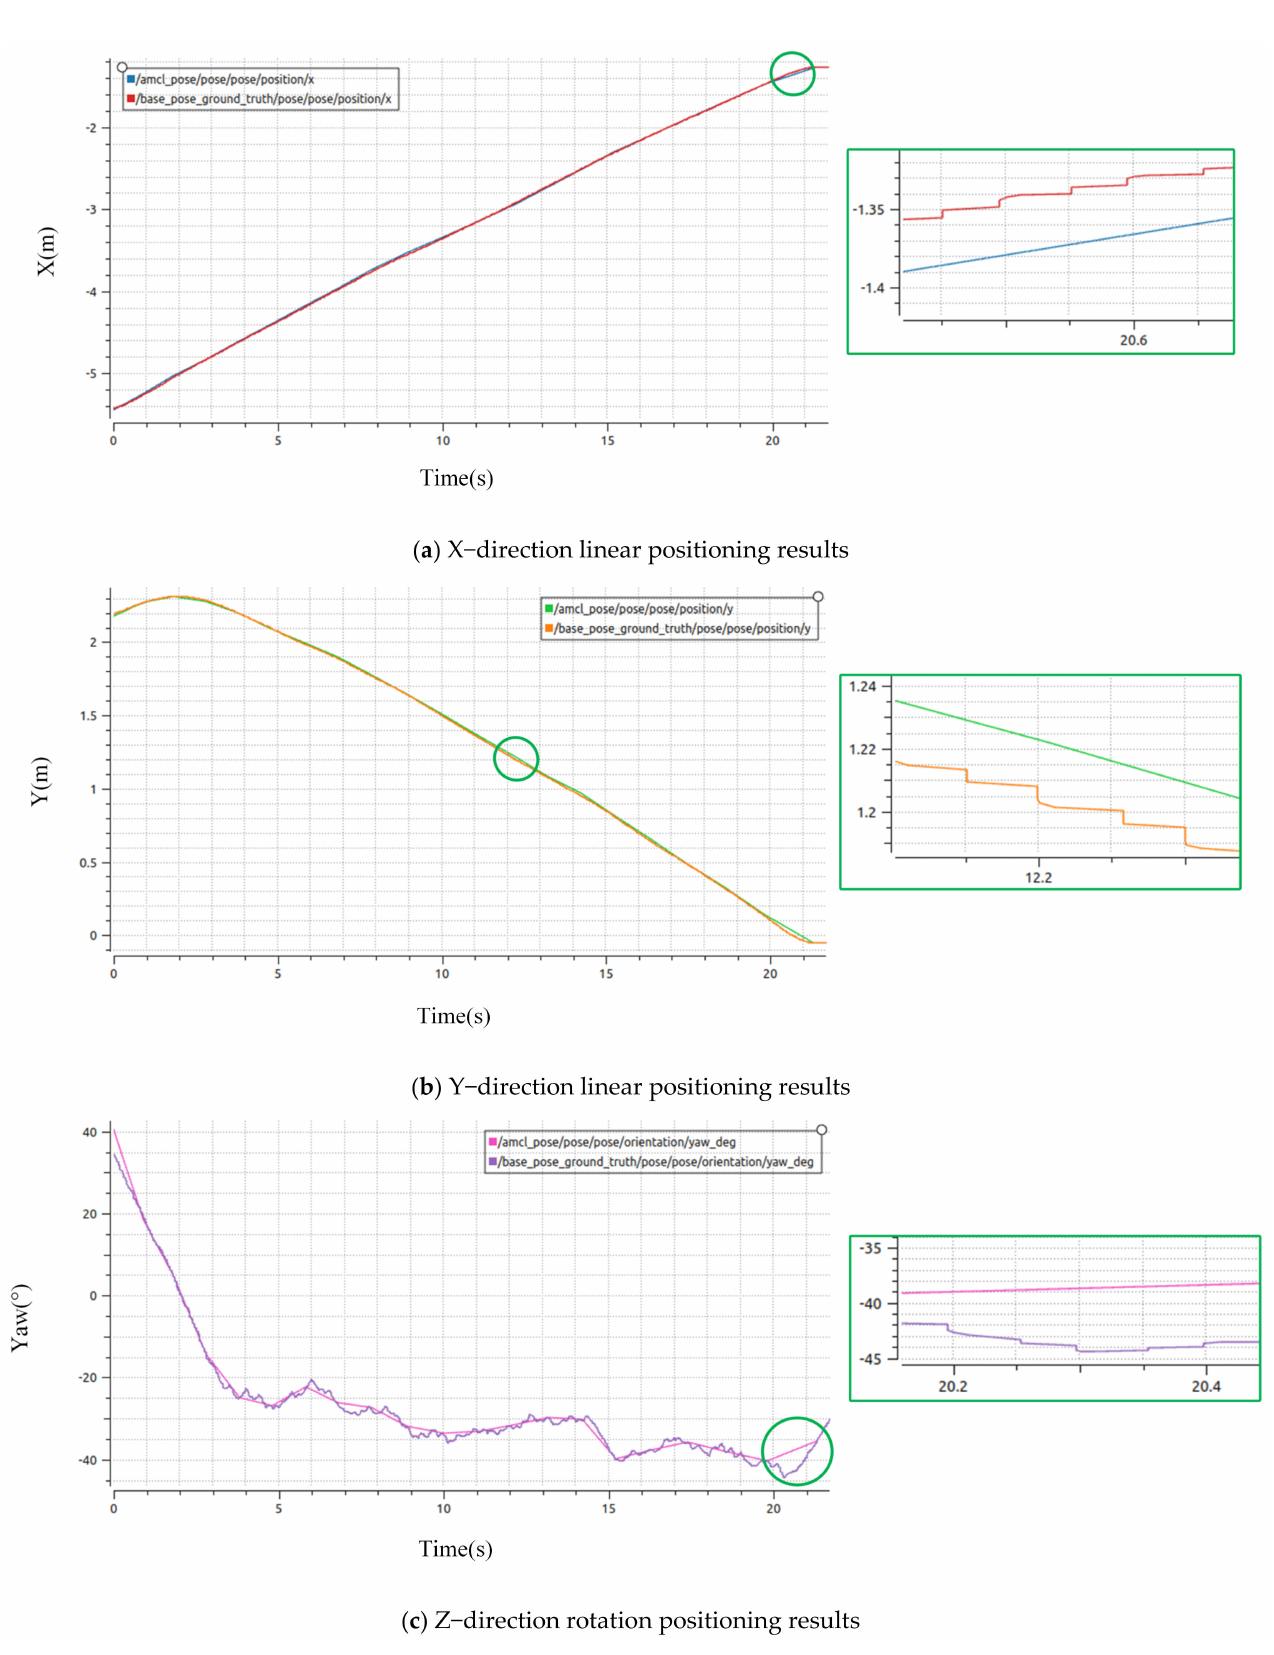
Figure 8. Results of the third group of AMCL simulation positioning